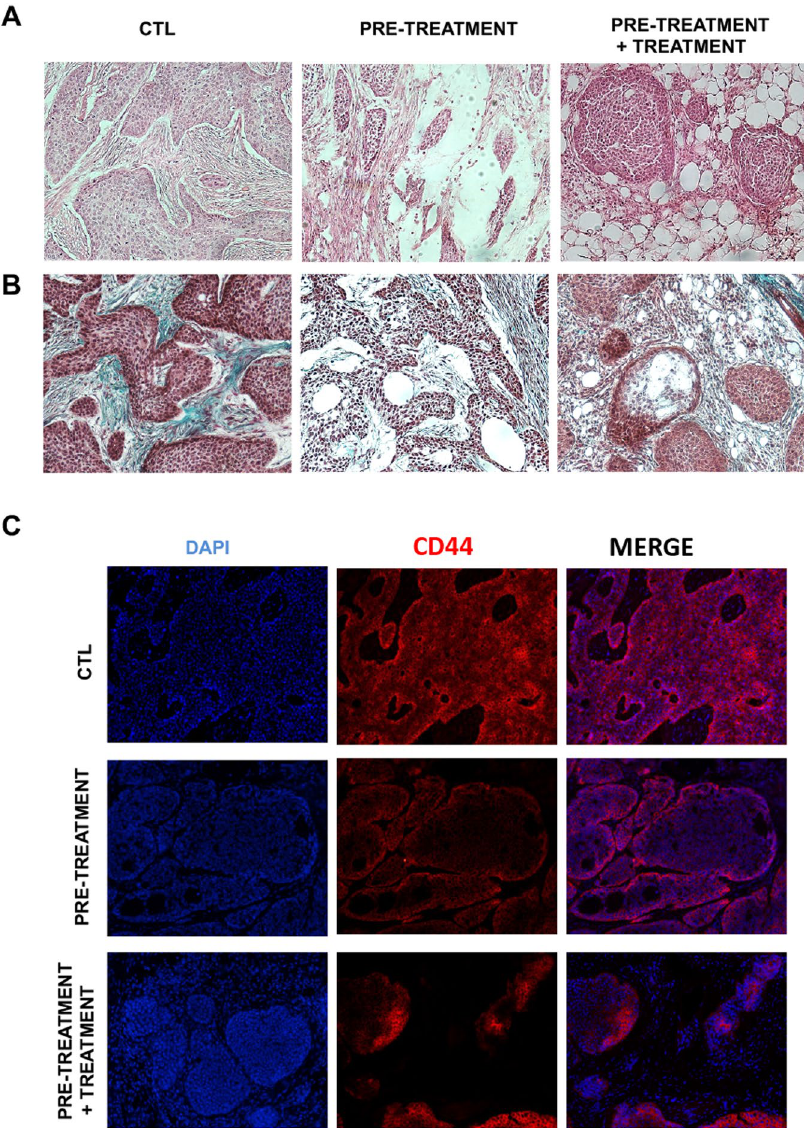
Figure 8. Effects of PRP on ECM deposition and pancreatic cancer marked CD44 expression. Representative images of tumour sections histologicaly staining with haematoxylin-eosin (H&E) ( A ) and Masson’s Trichrome (MS). ( B ) Tumours isolated from treated mice showed less fibrotic tissue (pink staining for the H&E test and green staining for the MS labellin) when compared with tumours isolated from control mice. ( C ) Immunofluorescence staining of pancreatic tumour sections with CD44 (red channel) demonstrated that tumours from non-treated mice had increased expression of CD44. Magnification, 10 ×